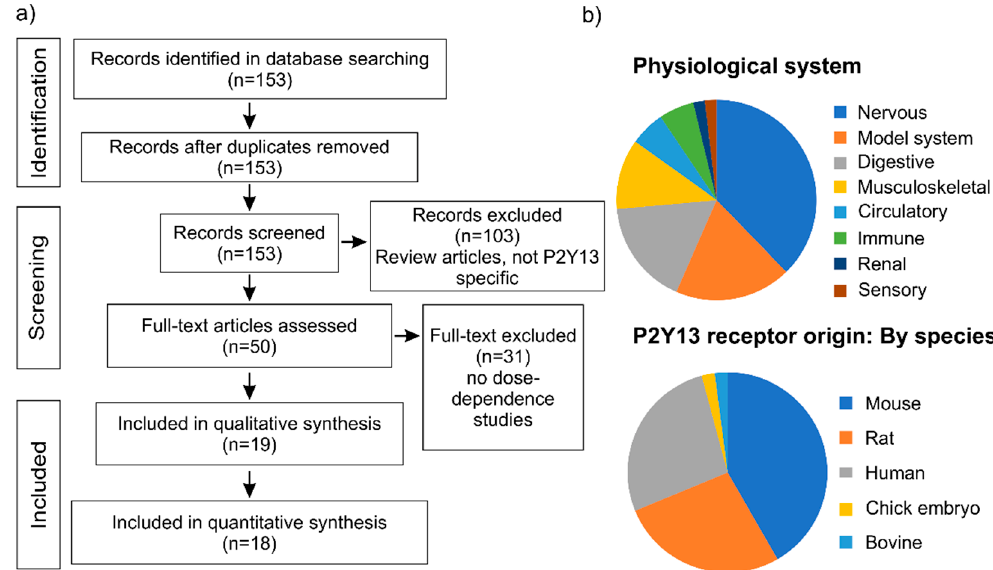
Figure 1. Screening and selection process. ( a ) Preferred reporting items for systematic reviews and meta-analyses (PRISMA), adapted. n indicates the number of studies ( b ) The pie chart indicates the distribution of P2Y13 studies obtained at the full-text screening level (n = 50) in different species in terms of the receptor’s origin and physiological systems. Studies performed in the heterologously-expressed P2Y13 receptor are indicated as model systems. Table 1. Overview of selected papers for systematic review and meta-analysis. The search strategy is included in Table S1. Each paper was assigned a quality score based on a developed questionnaire (Table S2), where 14 points indicated a high-quality paper. The study names marked in “red” were conducted in a model system with heterologous P2Y13 expression. ADP β S: adenosine 5 (cid:48) -O-(2-thiodiphosphate); CREB: cAMP-responsive element binding protein; 2MeSADP: 2-methylthio- adenosine diphosphate; MEPP: miniature end-plate potentials; ERK: extracellular signal-regulated kinase; IP 3 :